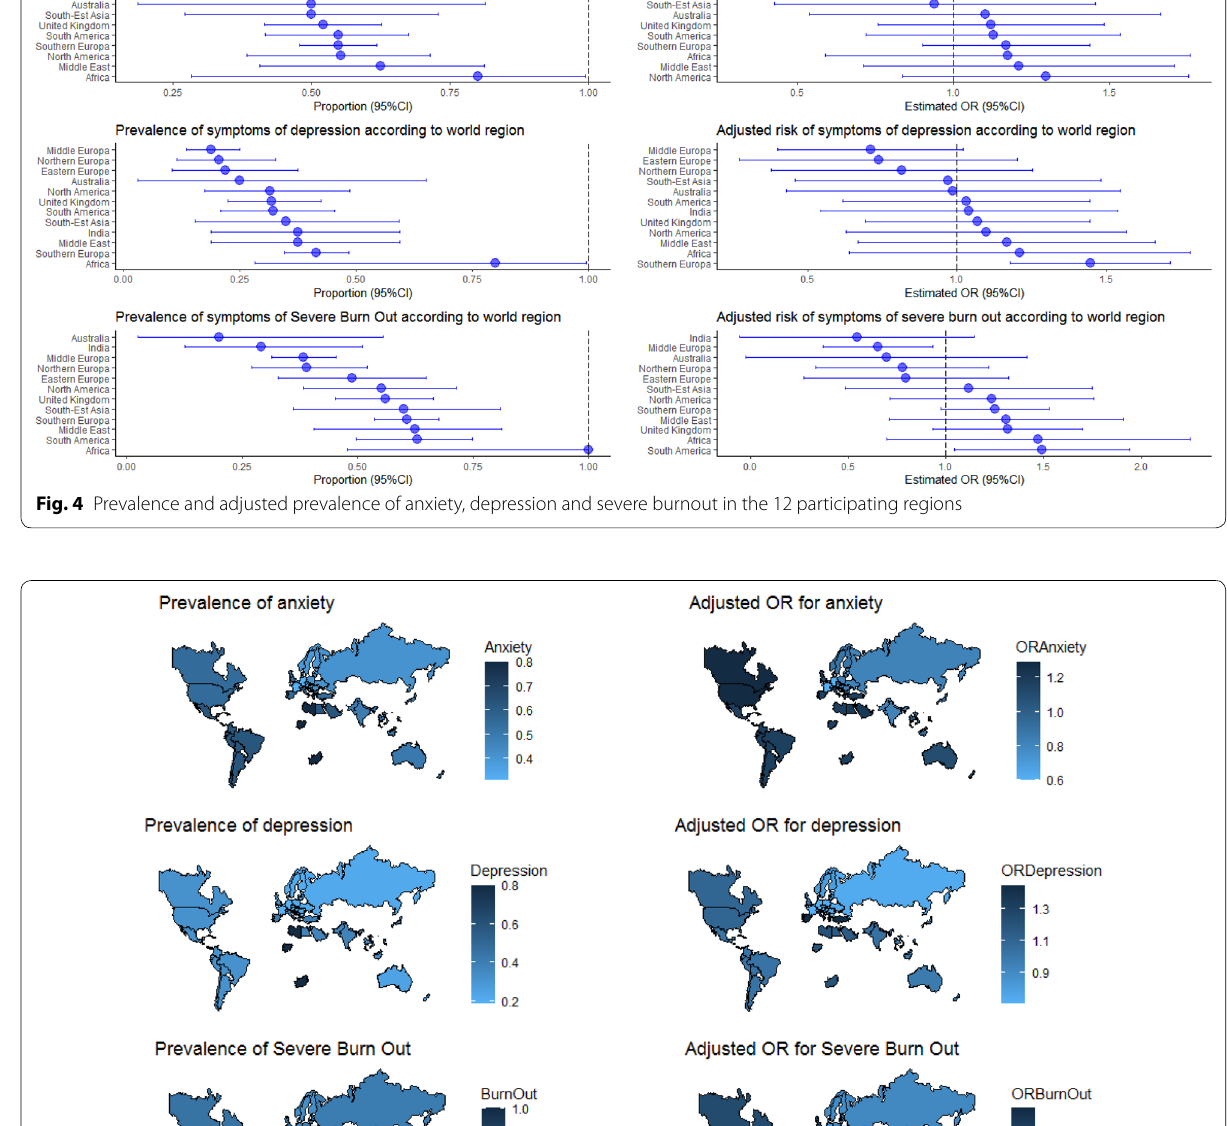
symptoms of anxiety (Fig. 2, panel a), depression (Fig. 2; panel b) or severe burnout (Fig. 2, panel c). Similarly, physicians with either of these symptoms provided signif- icantly lower scores to the ethical climate or the quality of the decision-making ratings (Fig. 2).